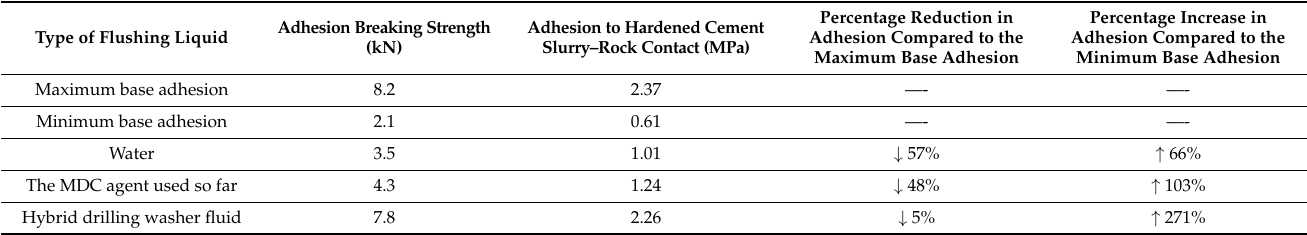
Table 4. Adhesion values for the hardened cement slurry–rock contact for selected washing liquids. Contact time of the liquid, 4 min; flow rate, 11.2